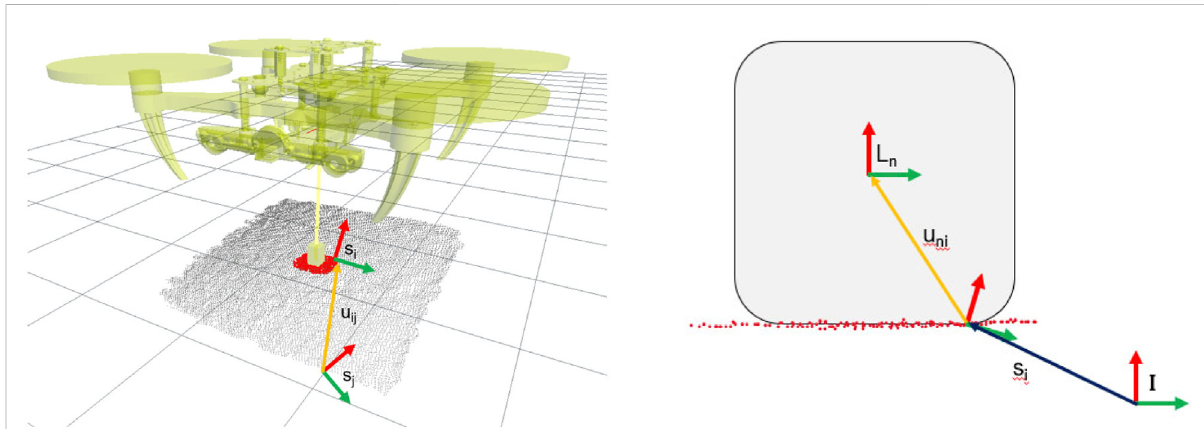
FIGURE 4 Graphical representation of the task model (left) and the link pose (right) used in the contact model. The task model is constructed as a rigid body transformation u ij in SE (3) from a task feature s j to a surface feature s i in the contact region. The link pose is computed as a rigid body transformation u ni in SE (3) from a surface feature s i in the contact region to the reference frame of the robot ’ s link. All the SE (3) poses s j , s i , L n are computed with respect to the inertia frame I